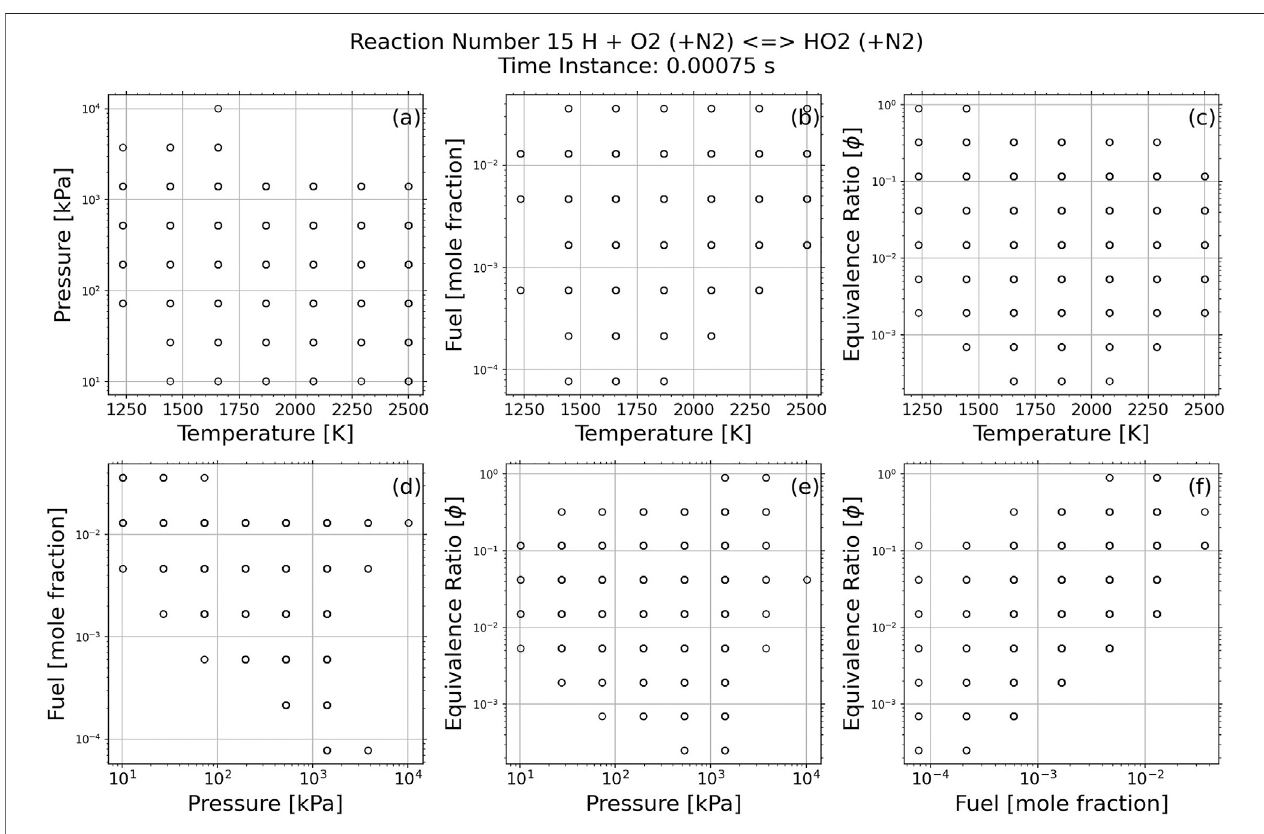
FIGURE 4 | Conditions where reaction 15 is most sensitive for species OH.